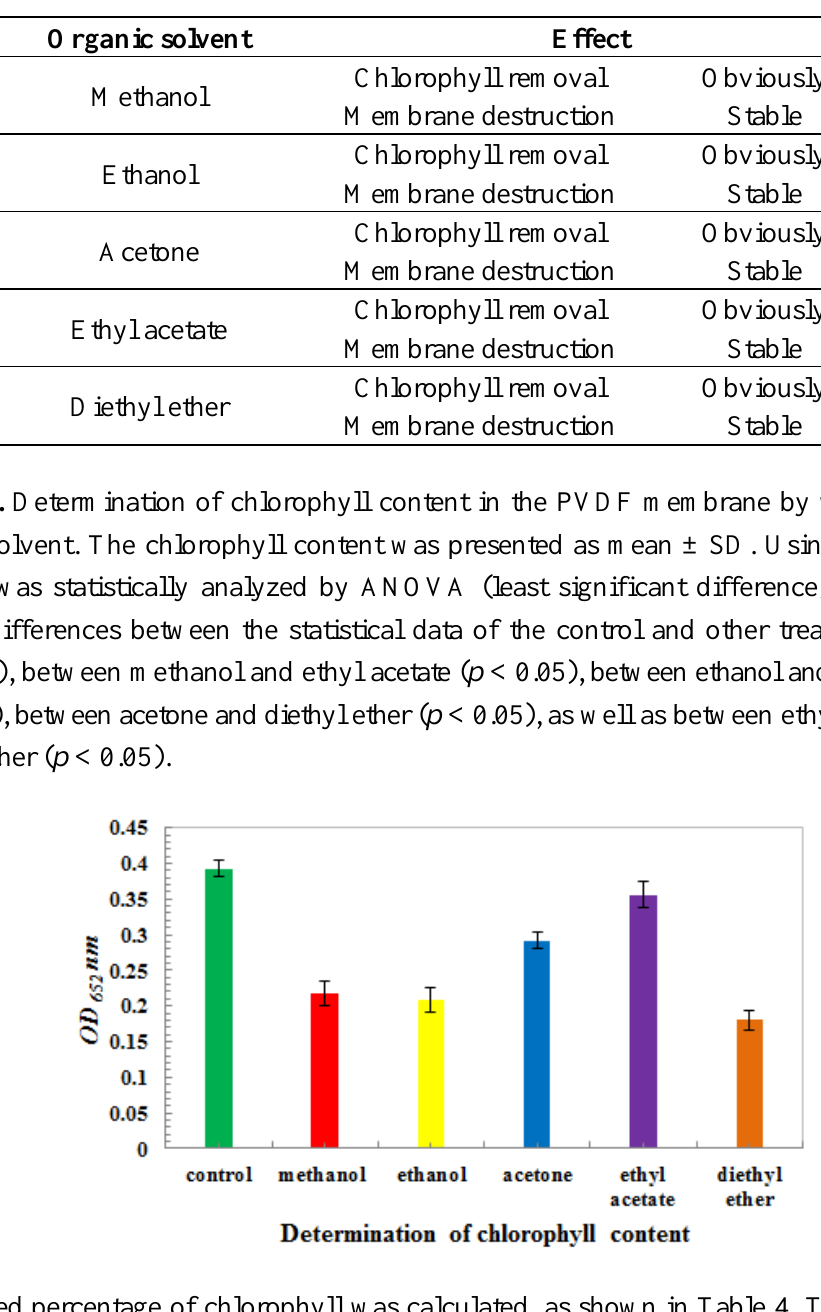
Table 3. Effect of chlorophyll removal and PVDF membrane destruction by organic solvents.